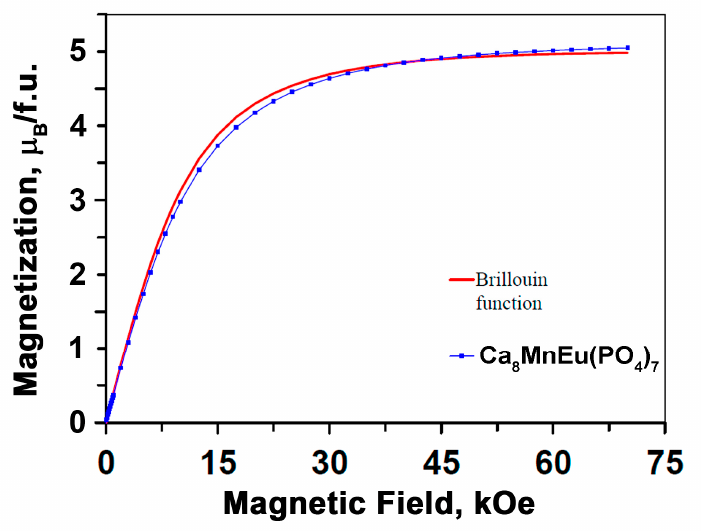
Figure 8. M versus H curves at T = 2 K for Ca 8 MnEu(PO 4 ) 7 . The red line shows the Brillouin function with g = 2, S = 5/2 and T = 2 K.